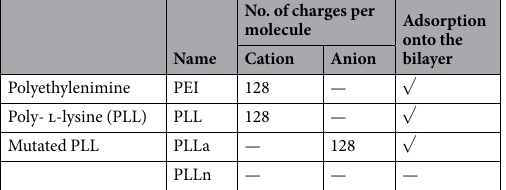
Molecular dynamics simulations of PEI and PLL in lipid bilayers. Linear random-coil polymers with different charges and structures were simulated in lipid bilayers with explicit water for 400 ns. Note that the sim- ulated lipid bilayers differ from realistic cellular membranes composed of various lipid components and protein receptors. Despite this limitation, simulations of lipid bilayers have successfully reproduced experimental obser- vations regarding the cytotoxicity of proteins and nanoparticles, and thus the dimyristoylglycerophosphocholine (DMPC) bilayer was used as a model membrane in this work 20, 21 . The simulated systems are listed in Table 2. The letters “a” and “n” following PLL indicate the polymers modified with anionic and neutral beads, respectively, to replace the cationic beads of PLL side chains. For example, “PLLn” designates the bilayer system with the neutrally mutated PLL. Figure 5 shows the initial and final snapshots of the simulations. Starting with the poly- mers above the bilayer surface, PEI, PLL, and PLLa bind to the bilayer surface, while PLLn does not, indicating that the polymer charge affects the interaction between polymers and bilayers. In particular, PEI and PLL bind more tightly to the bilayer than PLLa chains, indicating a stronger interaction with cationic polymers than with anionic polymers. This is expected, as anionic polymers cannot interact with anionic lipid phosphates 22 , whereas cationic polymers do and thus can insert more deeply into the bilayer 23, 24 . These configurations and the binding extent of the polymers were also confirmed by calculating density profiles. In Fig. 6, the PEI chains are mostly located in the lipid head-group region, whereas PLLn chains are positioned farthest from the head-group region, showing that the adsorption order (PEI > PLL > PLLa > PLLn) is consistent with Fig. 5. The cumulative numbers of the charged (or neutrally mutated) beads of polymers were also calculated as a function of the distance from the bilayer surface, showing that the number of PEI beads drastically increases near the bilayer surface, whereas those of other polymers do not, as shown in the density profiles. These results indicate that cationic polymers more strongly interact with lipid bilayers than do anionic polymers and that neutral polymers do not bind to the bilayer. This finding supports the above-mentioned experimental results regarding the different extents of toxicity for various polymers. Because cationic polymers have a stronger interaction with lipid bilayers, the different charge states of poly- mers may modulate the bilayer properties. To answer this question, the polymer-bilayer interactions were further quantified by calculating radial distribution functions (RDFs) between lipid phosphates and the charged (or neu- trally mutated) beads of the polymer. Figure 7 shows the peak heights in the order of PEI > PLL > PLLa > PLLn, indicating that cationic polymers have stronger electrostatic interactions with the bilayer surface, consistent with Figs 5 and 6. Note that although PEI and PLL have the same positive charge density, the RDF peak is much higher for PEI than for PLL. This is apparently because PLL chains consist of backbones and side chains, whereas PEI chains contain only backbones, so the charged beads of PEI are more accessible to the bilayer surface than the charged beads of PLL side chains, as visualized in Fig. 5. In Fig. 7 (bottom), the RDFs between lipid head groups and PLLa side chains show that the anionic beads of PLLa tend to electrostatically interact with cationic cholines of lipids rather than with anionic phosphates, which explains why there is less adsorption of anionic polymers onto the bilayer in Fig. 6. These simulation findings indicate that charged polymers strongly interact with lipid bilayers, whereas neutral polymers do not, illustrating the effect of polymer charge on the interaction between polymers and lipid bilayers. In particular, cationic and anionic polymers interact with lipid phosphates and cholines, respectively, leading to a stronger adsorption of cationic polymers onto the bilayer. Additionally, our simulations show that linear poly- mers with only charged backbones (PEI) have a stronger electrostatic interaction with the bilayer than those with backbones and charged side chains (PLL) because the charged beads of the former are sterically more accessible to the lipid head groups. This dependence on the structure and charge state of linear polymers agrees well with the above experimental results showing a higher toxicity for cationic polymers than for anionic and neutral polymers and that linear PEI is more toxic than non-linear PLL.